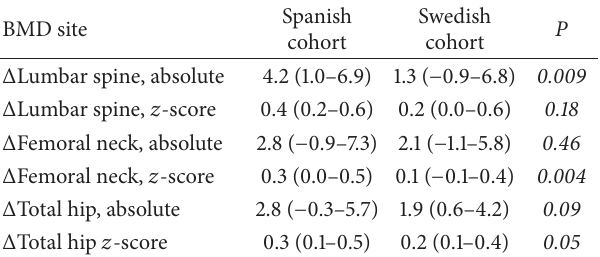
Table 4: Change in bone mineral density (Δ) after surgery for primaryhyperparathyroidism.Changeinabsolutevaluesinpercent. Changein 𝑧 -scoreinarithmeticdifference.Medians(IQR).Kruskal- Wallis